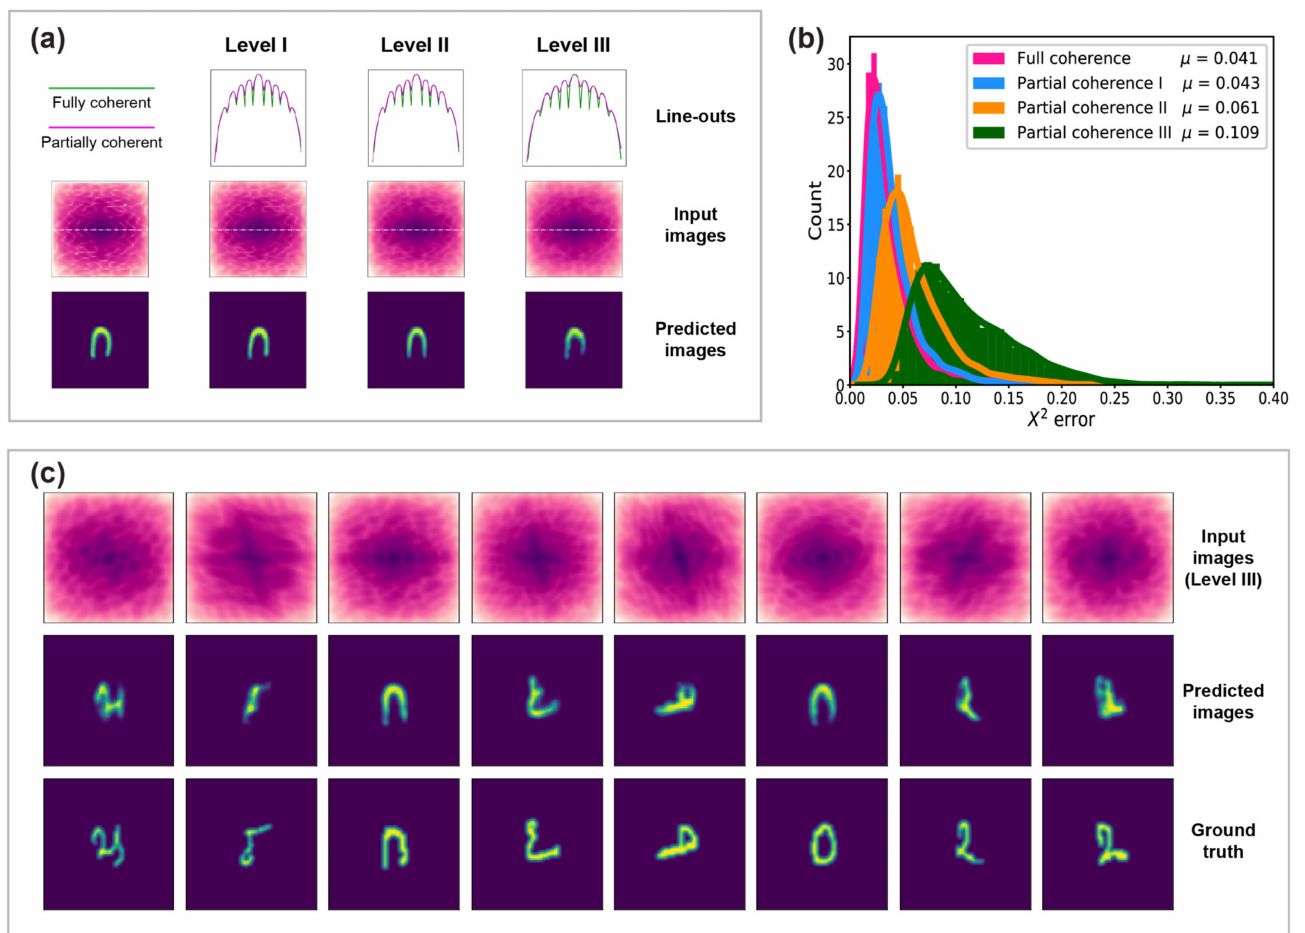
Figure 4. ( a ) Four input images and corresponding predicted images. The input image on the left side of the second row is a fully coherent diffraction image and the rest three images are partially coherent diffraction images. There are three different degrees of coherence (defined as the level I, II and III) as clearly seen in the first row, which is a 1D plot of horizontal lines depicted as white dashed lines on the images in the second row. ( b ) The histograms of errors for different datasets. The average ( µ ) of X 2 error increases as the degree of coherence decreases. ( c ) The first row shows a series of input images, which are the level III partially coherent diffraction images. The second and third row show the predicted images and ground truth,